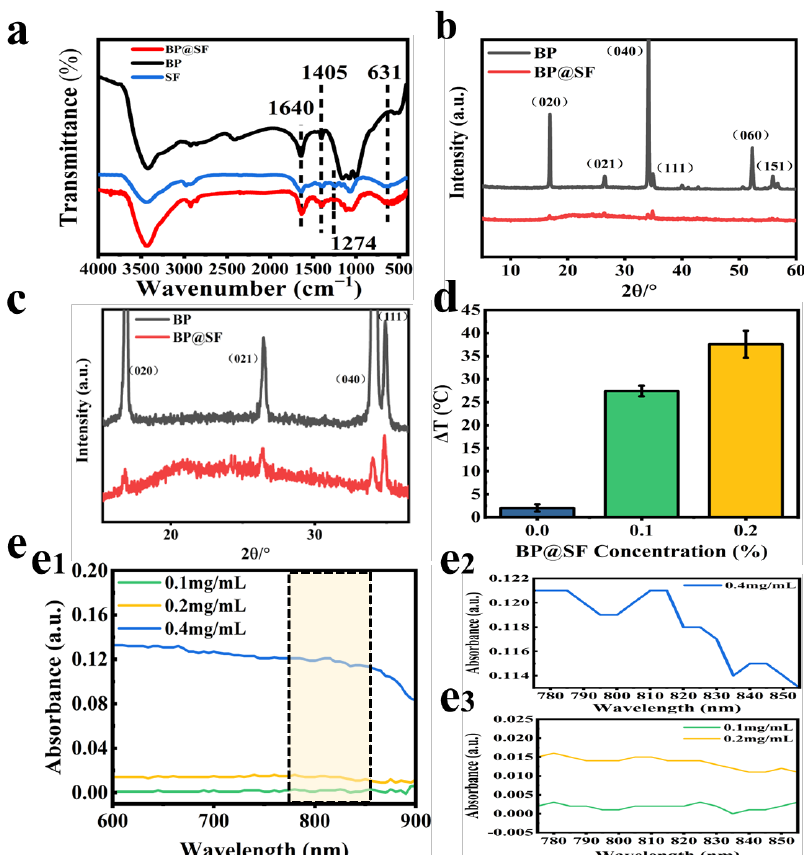
Figure 2. Characterization of BP@SF. ( a ) XRD from 5 to 60°; ( b ) XRD from 15 to 36°; ( c ) FTIR; ( d )